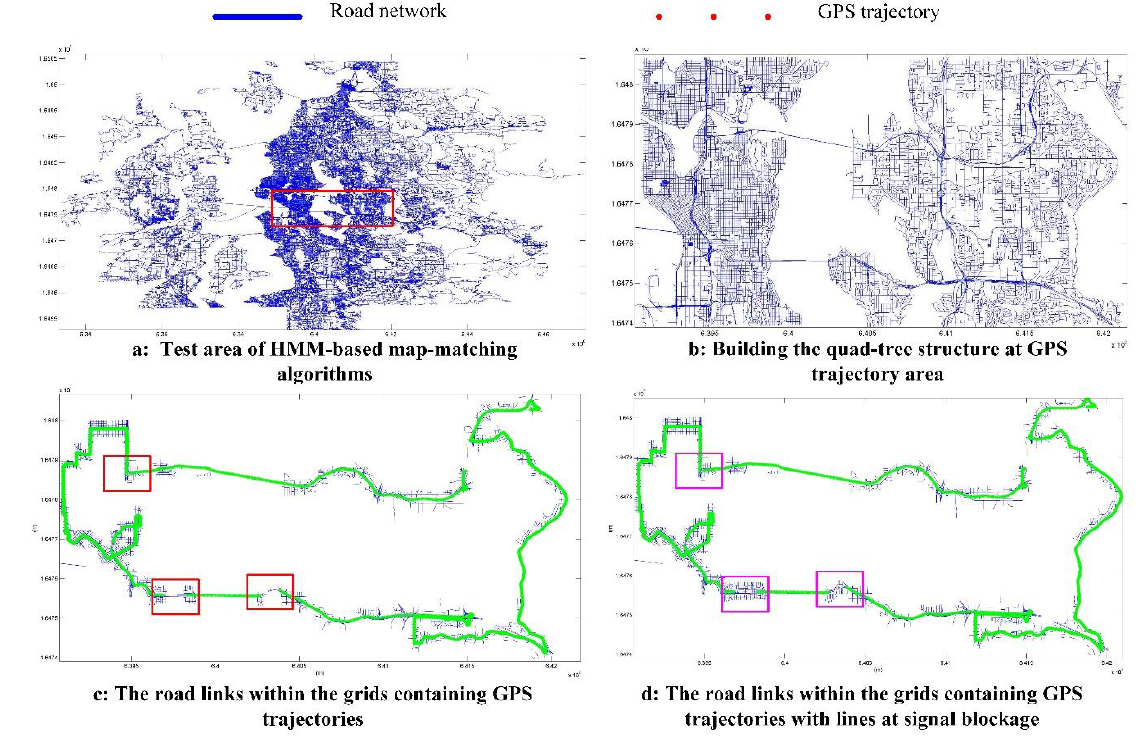
Figure 9. Procedures for map-matching with